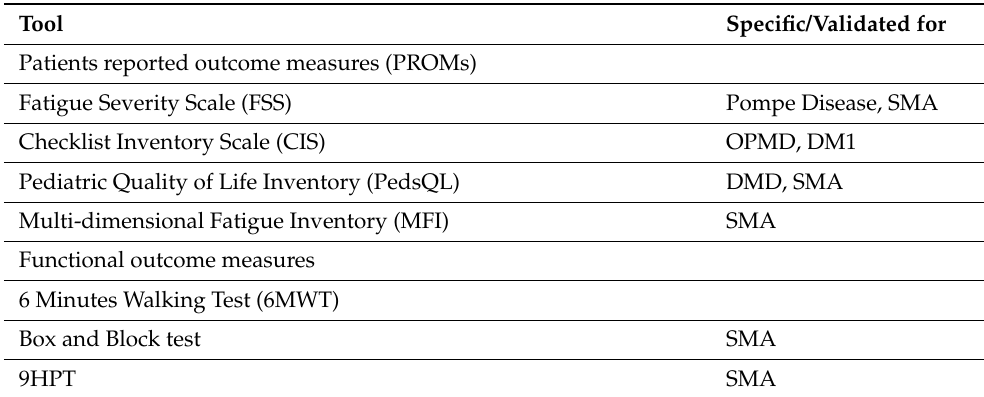
Table 2. Overview of fatigue assessment tools in different neuromuscular diseases.